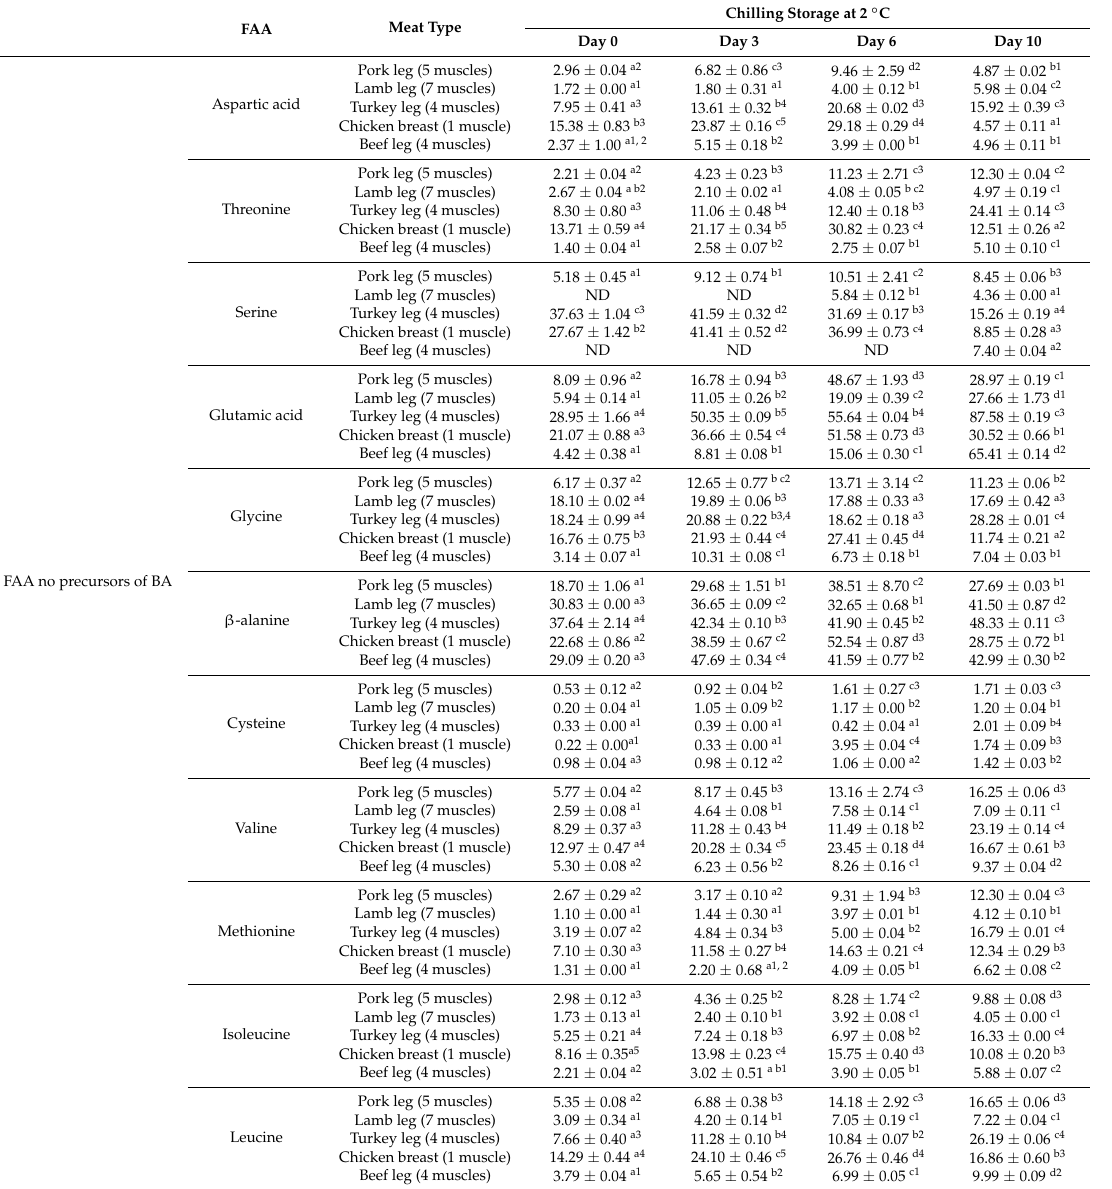
Table 3. Free amino acids (FAA) concentration (mg/100 g) of the fresh different meat types during chilled storage at 2 ◦